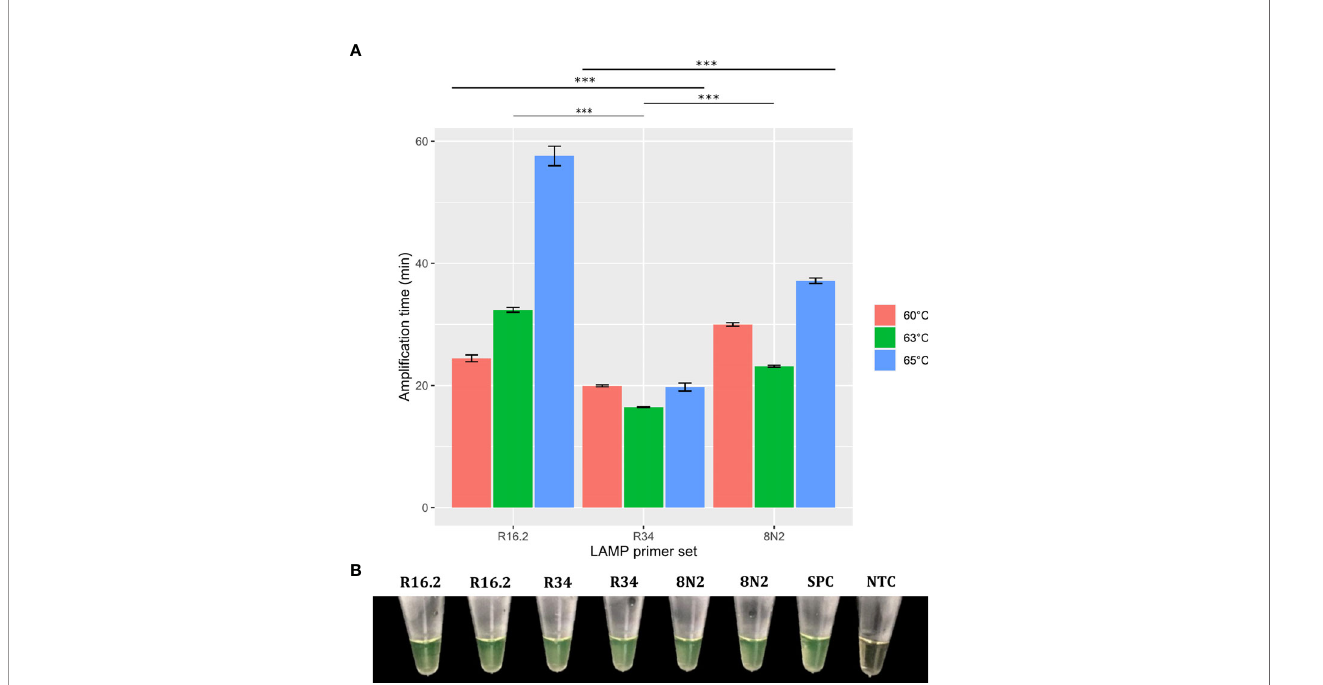
FIGURE 6 | Effects of temperature and R16.2, R34, and 8N2 primer sets on RT-LAMP assay performance. Error bars represent the standard deviations of the ampli fi cation time mean from independent experiments performed in duplicate. ***P < 0.001. Signi fi cance analyzed by one-way analysis of variance (ANOVA) (A) . RT- LAMP assays using the R16.2, R34, and 8N2 primer sets for SARS-CoV-2 detection were considered positive when the solution color changed from brown to green (B) . NTC, negative non-template control; SPC, SARS-CoV-2 positive